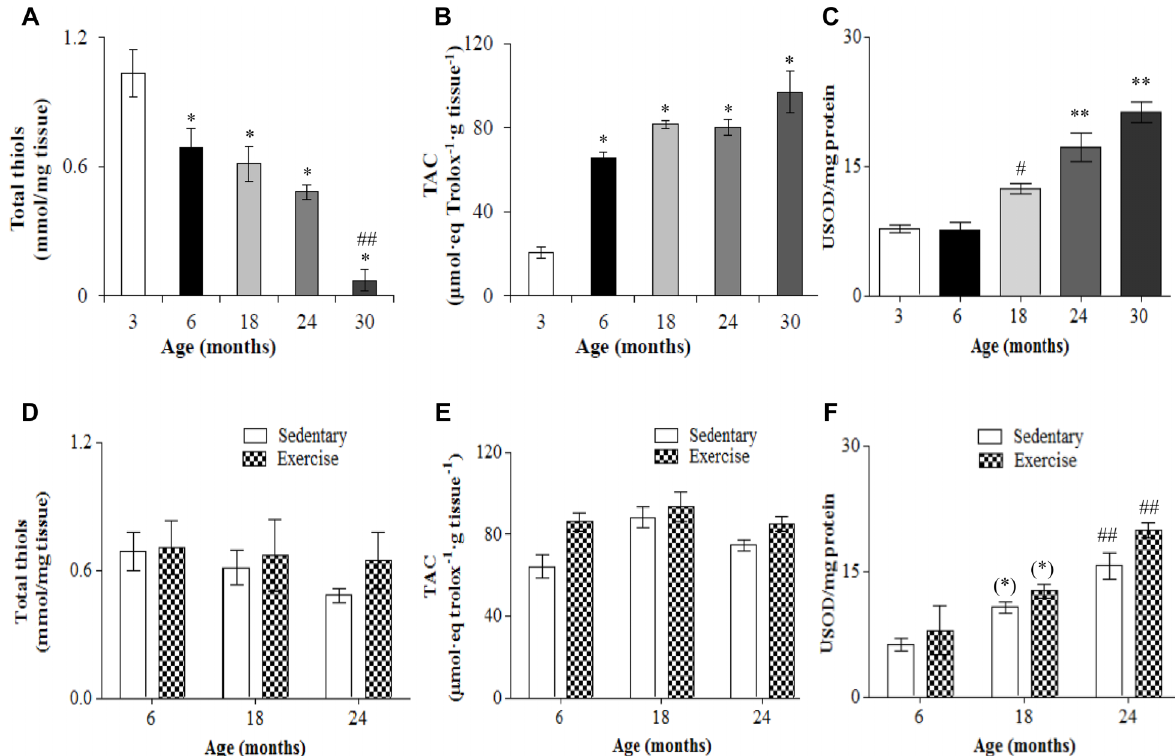
Figure 7. Total thiol content ( A , D ), total antioxidant capacity (TAC) ( B , E ), and superoxide dismutase (USOD) activity ( C , F ) in the lumbosacral spinal cord of Wistar rats of different ages ( A – C ) and after 12 weeks of treadmill running ( D – F ). Data are reported as mean ± SE. *P o 0.05 compared to 3-month-old rats; # P o 0.05 compared to 3- and 6-month-old rats; ## P o 0.05 compared to 6- and 18-month- old rats; **P o 0.05 compared to 3-, 6-, and 18-month-old rats; ( * ) P o 0.05 compared to 6-month-old rats of the same experimental group (one-way ( A – C ) and two-way ( D – F ) ANOVA followed by Tukey ’ s post hoc